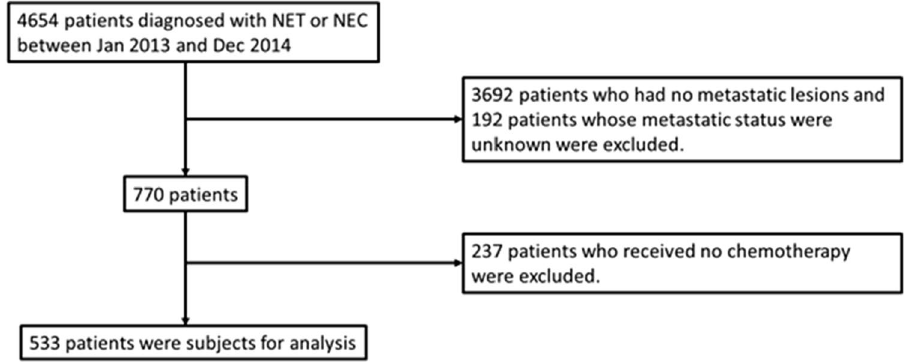
Figure 1. Flowchart for extraction of